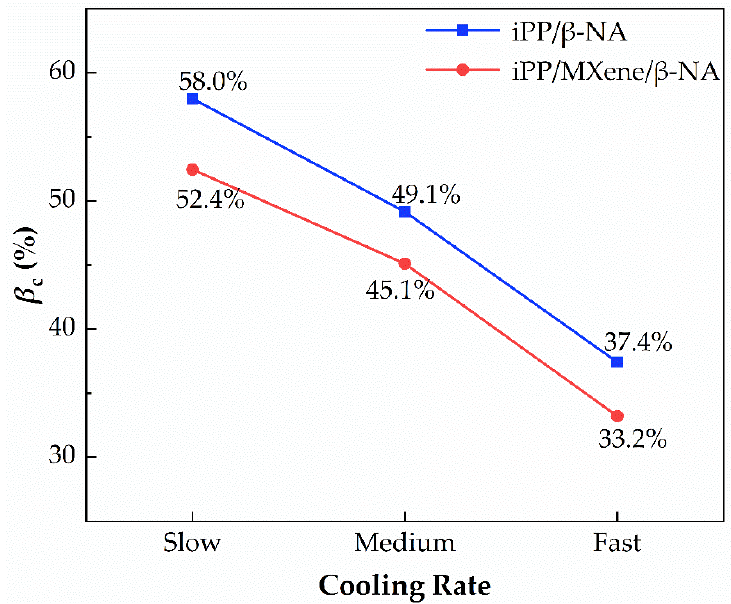
Figure 14. β c of iPP/ β -NA and iPP/MXene/ β -NA of different thermal histories.